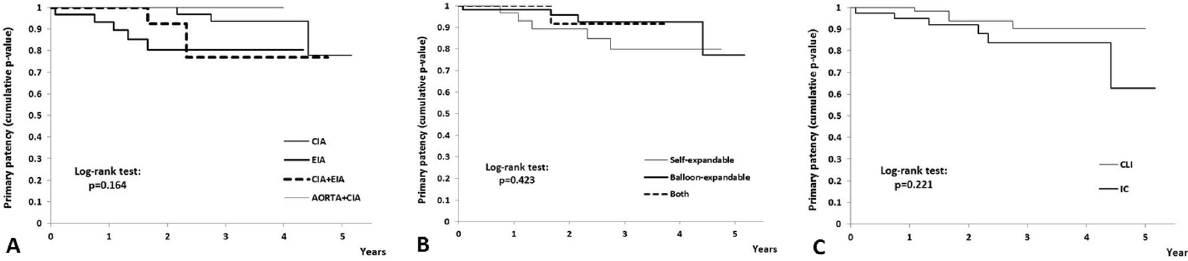
Fig 3. Kaplan-Meier primary patency rates. (A) For aorto-iliac segment subjected to endovascular treatment. (B) For stent type. (C) For patients with CLI and IC.